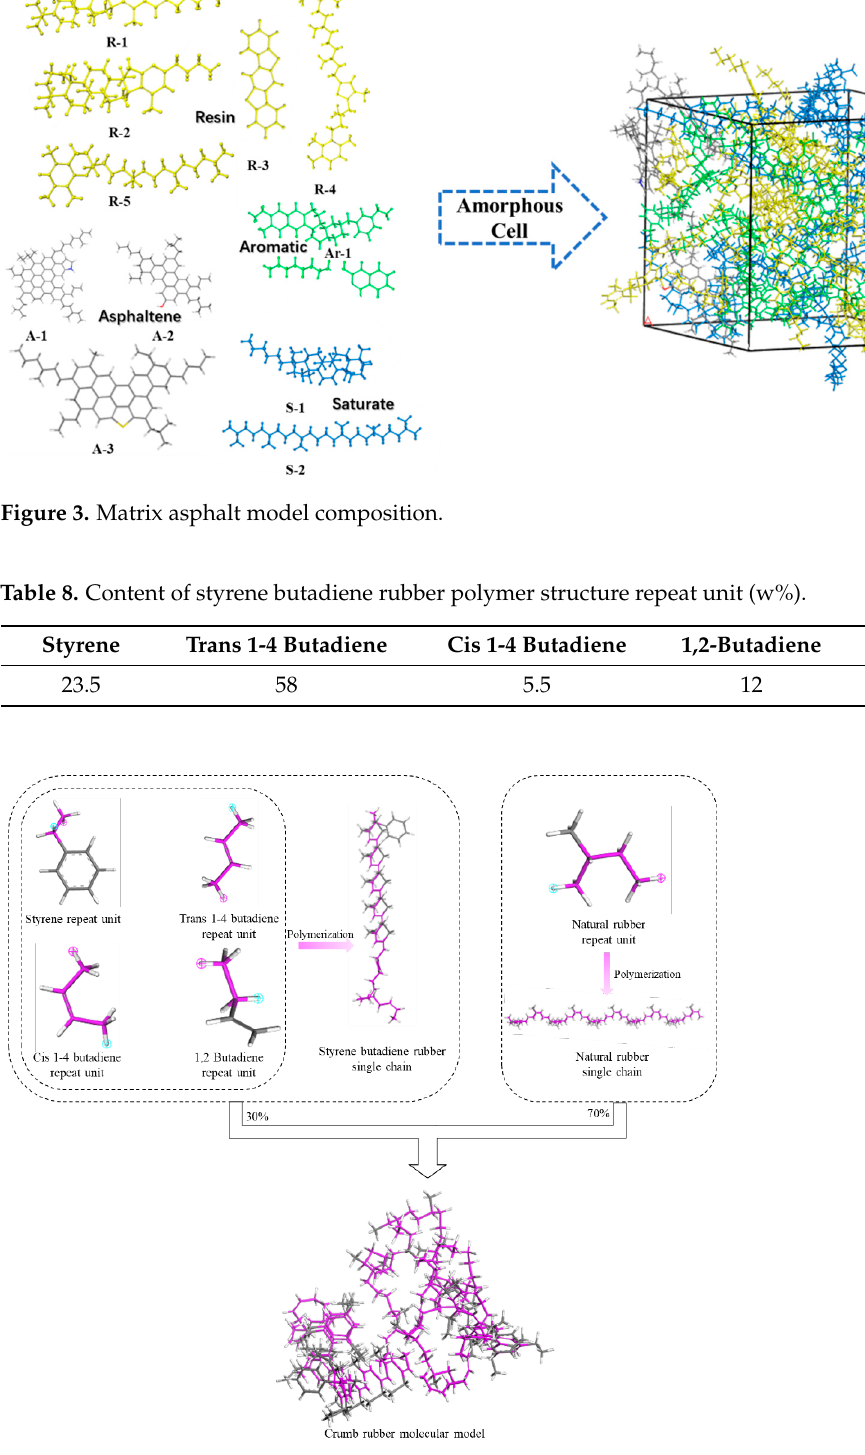
Figure 4. Construction process of the crumb rubber molecular group model.